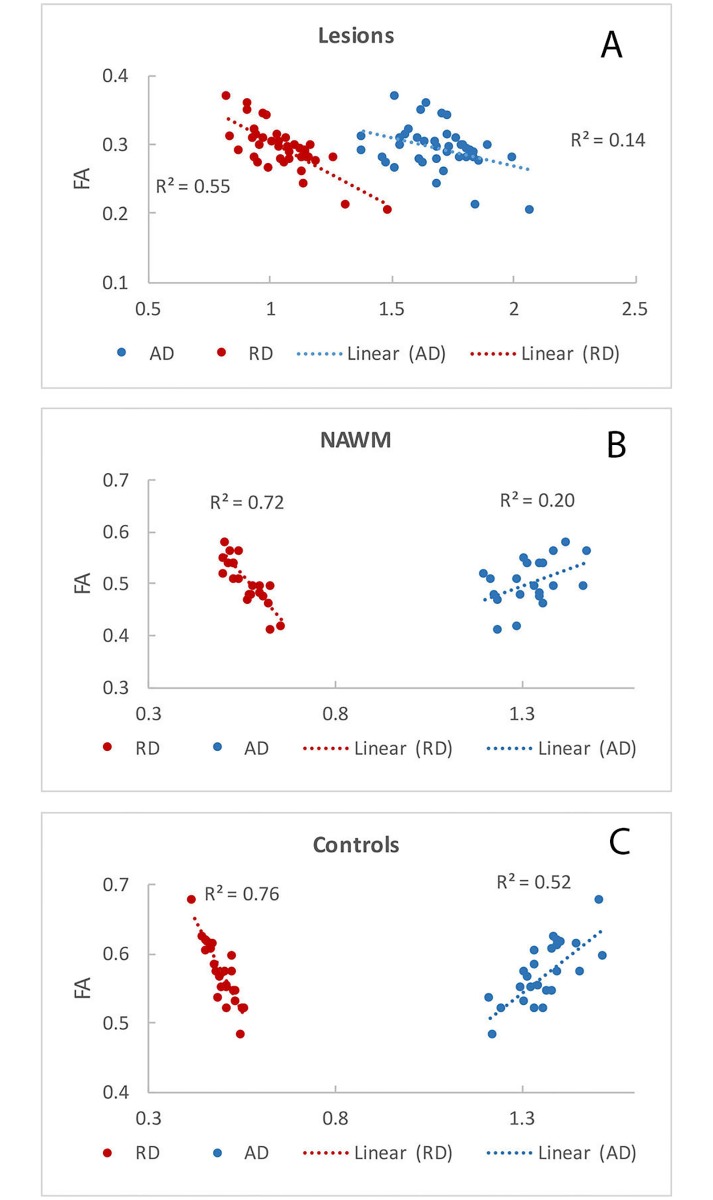
Correlation between anisotropy (FA) and parallel and perpendicular diffusivities (AD and RD) in OR lesions (a), OR NAWM (b) and OR of normal controls (c).Horizontal axes represent diffusivity values x10−3 mm2 s−1.